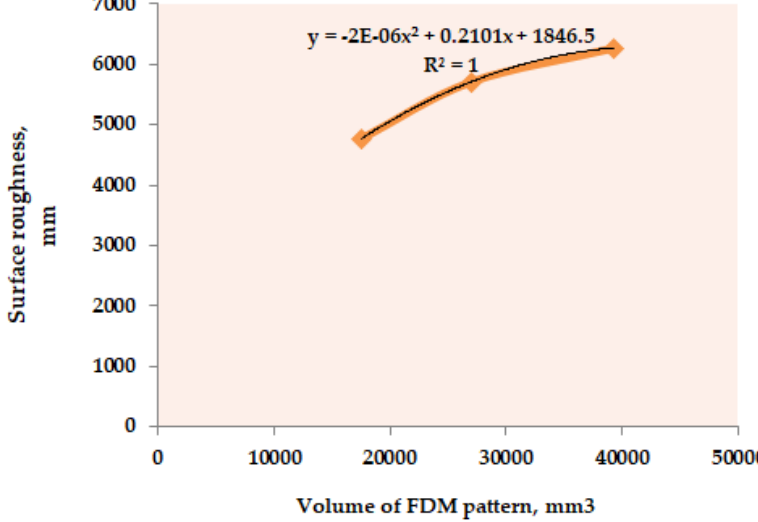
Figure 6. Surface roughness versus volume of FDM pattern plot.